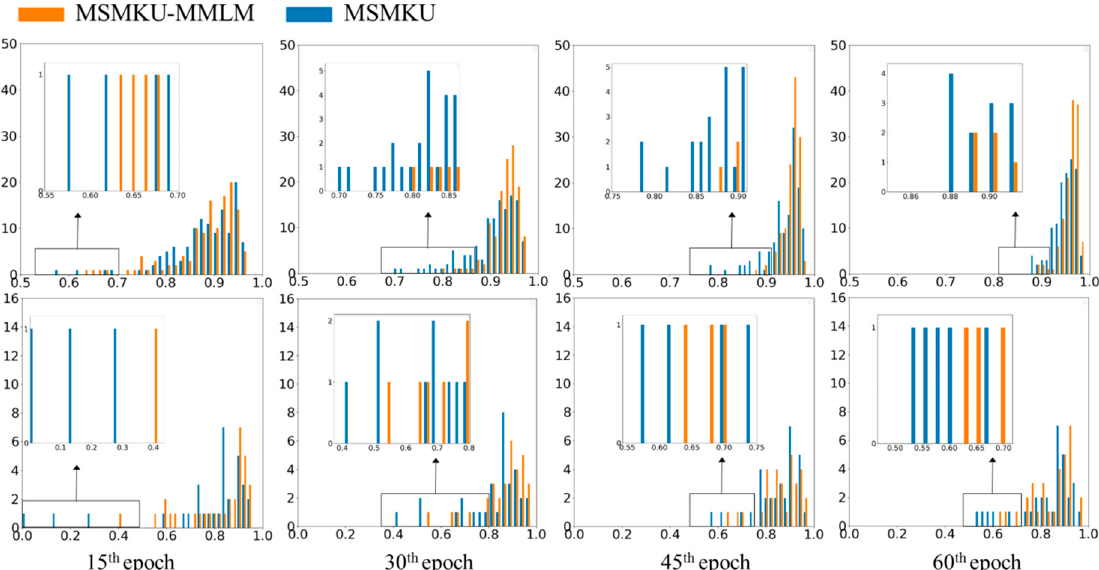
Figure 8. Histograms of the F -scores by MSMKU–MMLM and MSMKU on OC in one fold of the RIM-ONE-V3 dataset. The histograms on the first row are results on the training set and the histograms on the second row are the results on the test set. From the first column to the fourth column, the histograms are results trained after 15th, 30th, 45th and 60th epoch, respectively. The orange histograms refer to results by MSMKU–MMLM, while the blue histograms indicate the results by MSMKU. The horizontal axis represents F -scores, and the vertical axis represents the number of fundus images.